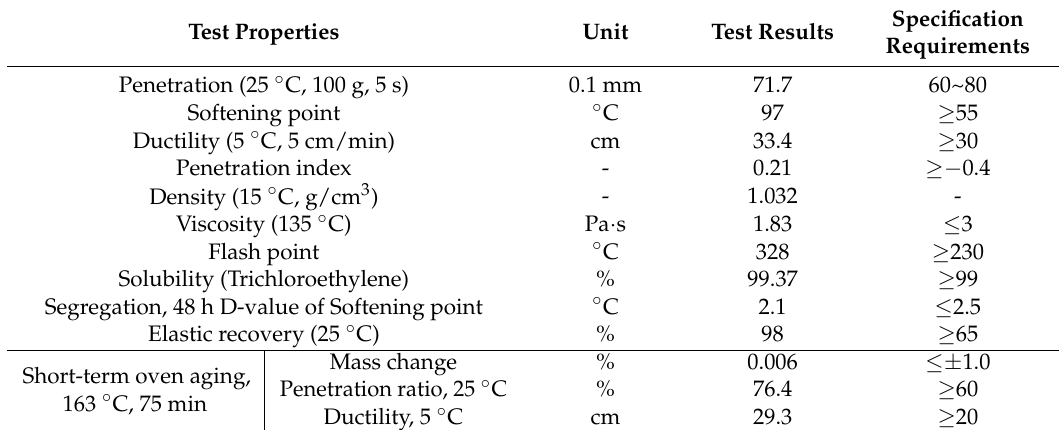
Table 1. Technical indicators of the asphalt